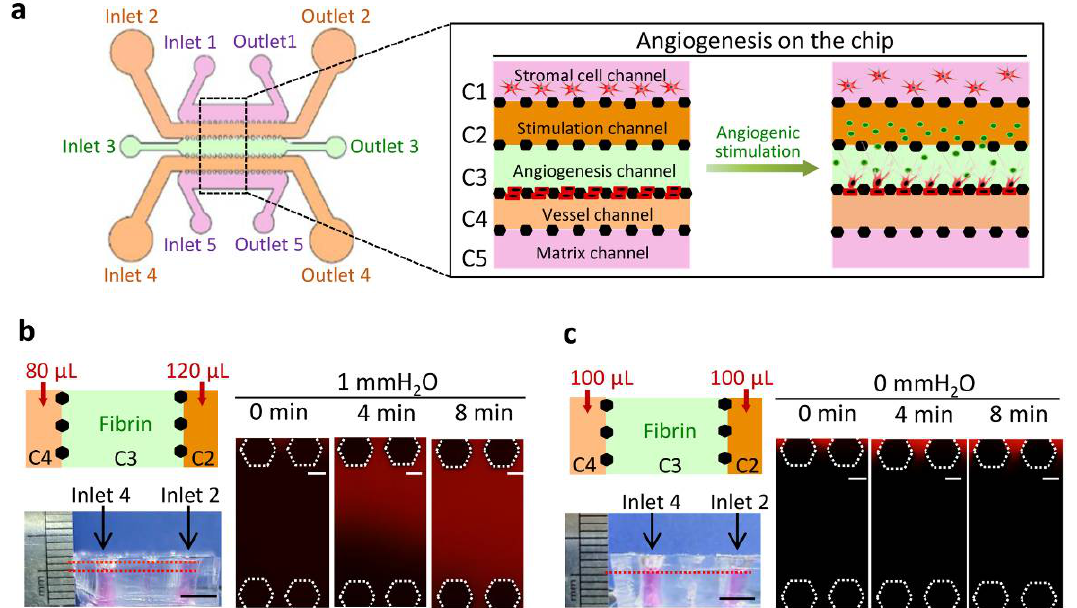
Figure 1. Chip design and characterization of IF. ( a ) Schematic overview (left) and channel configuration (right) of the microfluidic chip designed for the induction of angiogenesis. ( b ) IF generation in fibrin in channel C3. Left top: Different volumes of media were added into the channels C2 (120 µ L) and C4 (80 µ L) to produce a hydrostatic pressure difference, and they were changed every 12 h. Hydrostatic pressure of 1 mmH 2 O was generated when the media was just added into the channels C2 and C4. Left bottom: A Photo showed the sideview of inlet volumes. Right: Fluorescence images of TRITC-dextran (70 kDa, red) flowing through acellular fibrin in the channel C3 at 0, 240, and 480 s under the hydrostatic pressures of 1 mmH 2 O. ( c ) Static condition in the fibrin in channel C3. Left top: The same volumes of media were added into the channels C2 and C4 (100 µ L), and the media were changed every 12 h. Left bottom: A photo showed the sideview of inlet volumes. Right: Fluorescence images of TRITC-dextran (70 kDa, red) in fibrin at 0, 240, and 480 s under the hydrostatic pressures of 0 mmH 2 O. Scale bars, 5 mm (photos in ( b , c )) and 100 µ m (fluorescence images in ( b , c )).